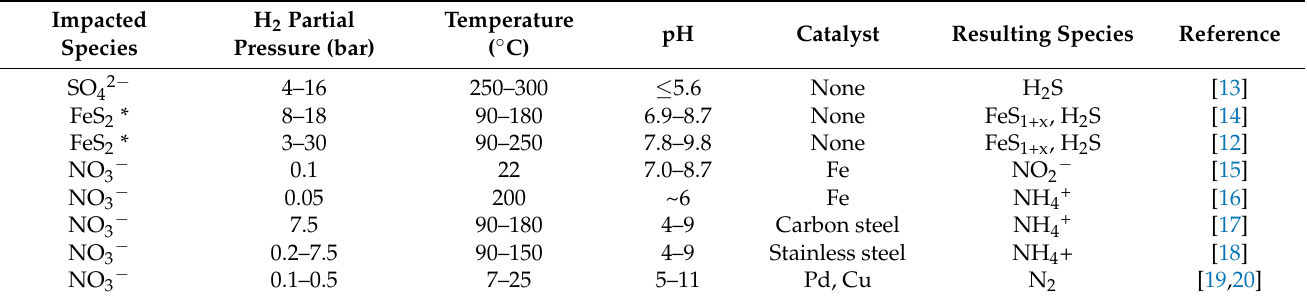
Table 1. Some examples of abiotic reductions due to H 2 under experimental laboratory